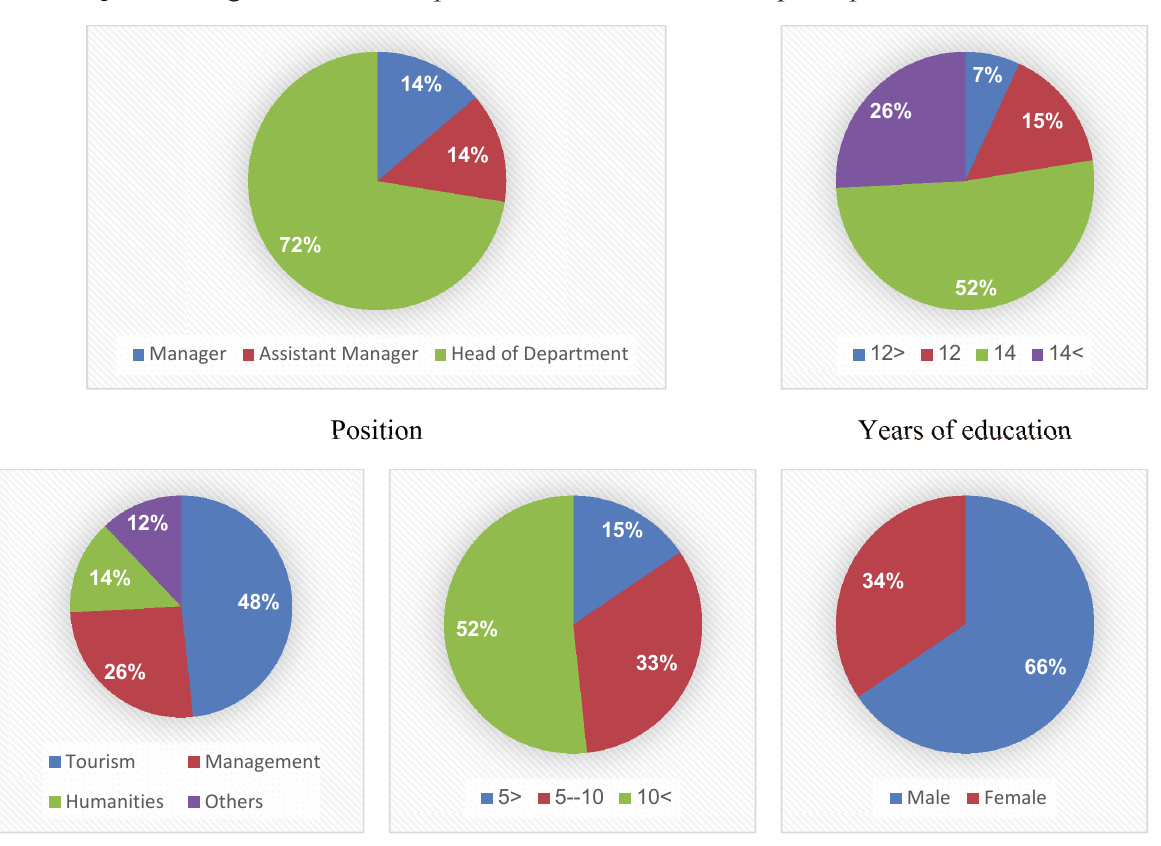
Fig. 2. Personal characteristics of the